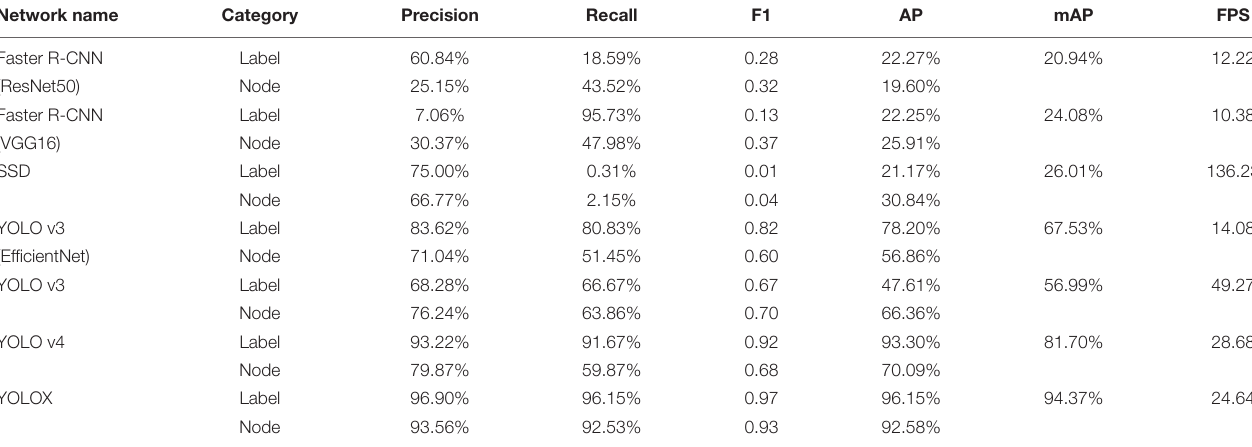
TABLE 1 | Detection effects of different networks on test